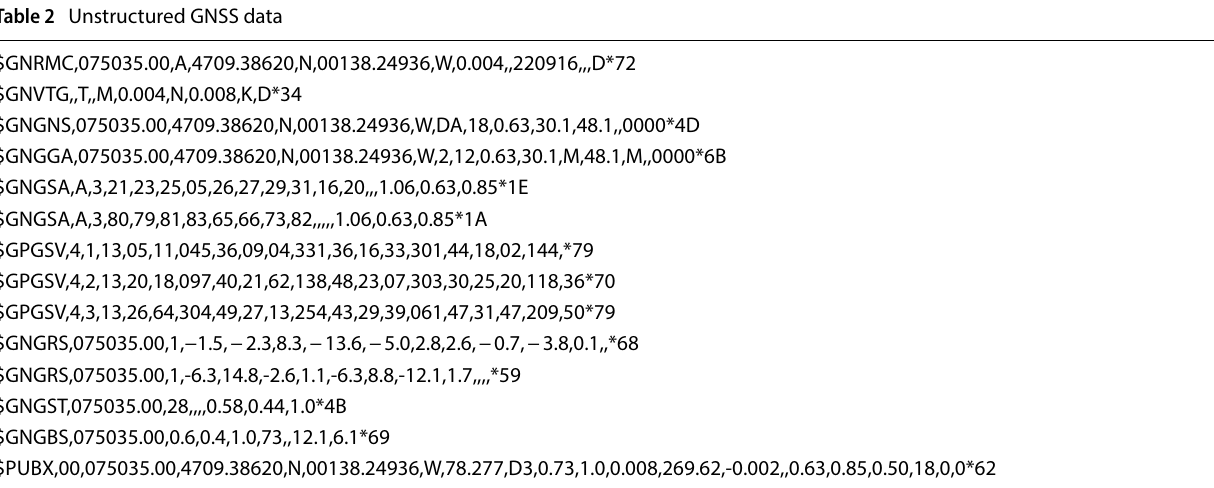
Table 2 Unstructured GNSS